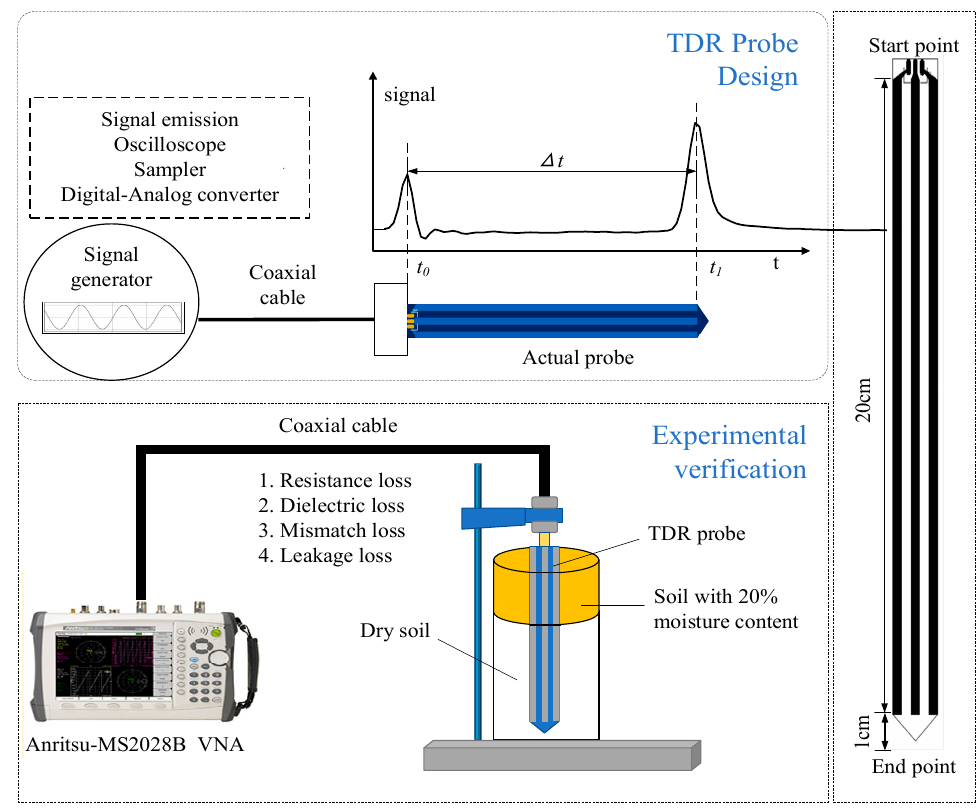
Figure 2. Schematic diagram of probe and measurement system.